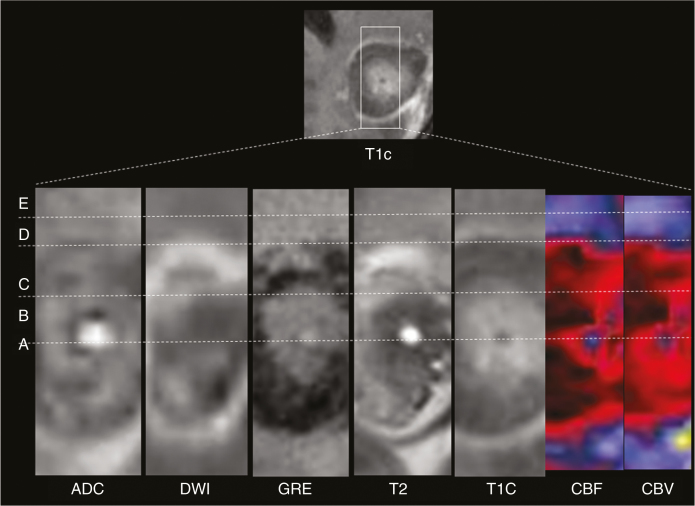
Concentric perilesional zones following LITT: ADC map, DWI, GRE, T2, T1 postcontrast (T1C), blood flow (CBF), and blood volume (CBV) images obtained 3 weeks after LITT ablation of a left parietal lesion in a 55-year-old male patient with recurrent GBM. These images demonstrate a lesion comprising five concentric zones: (A) probe track, (B) central zone, (C) peripheral zone, (D) peripherally enhancing rim, and (E) marginal zone (edema). Note that the concentric zones appear as inverse images on T1C and T2 images. Perfusion images (blood flow (CBF) and blood volume (CBV) demonstrate decreased blood volume in the marginal zone and in the peripherally enhancing rim.